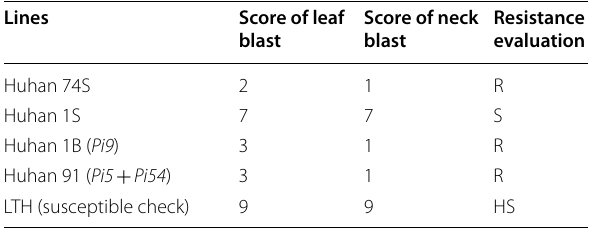
Table 2 Evaluation of leaf and neck blast resistances of